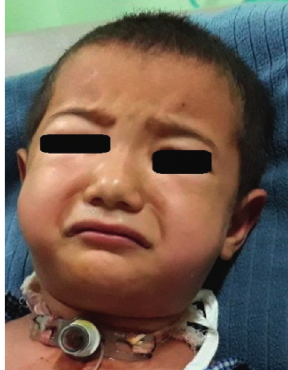
Figure 2: Preoperative chest X-ray.